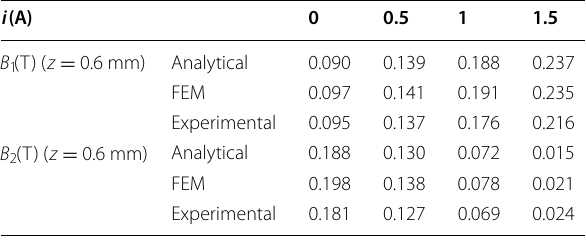
Table 7 Comparison of magnetic flux densities under different currents and displacements